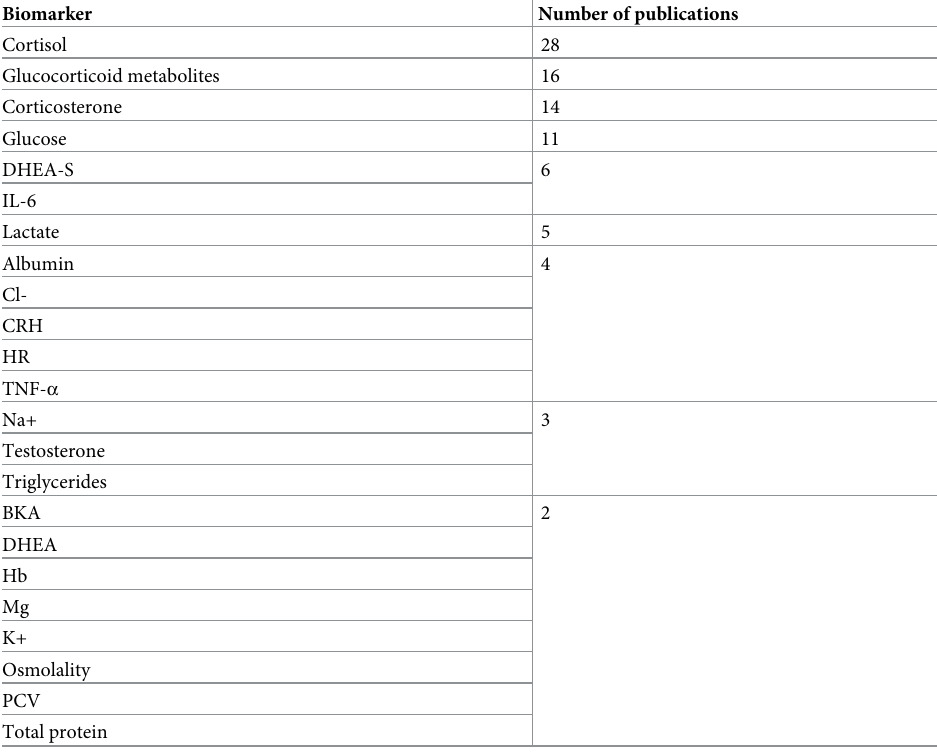
Table 2. Biomarkers used to make direct assessments about allostatic load in